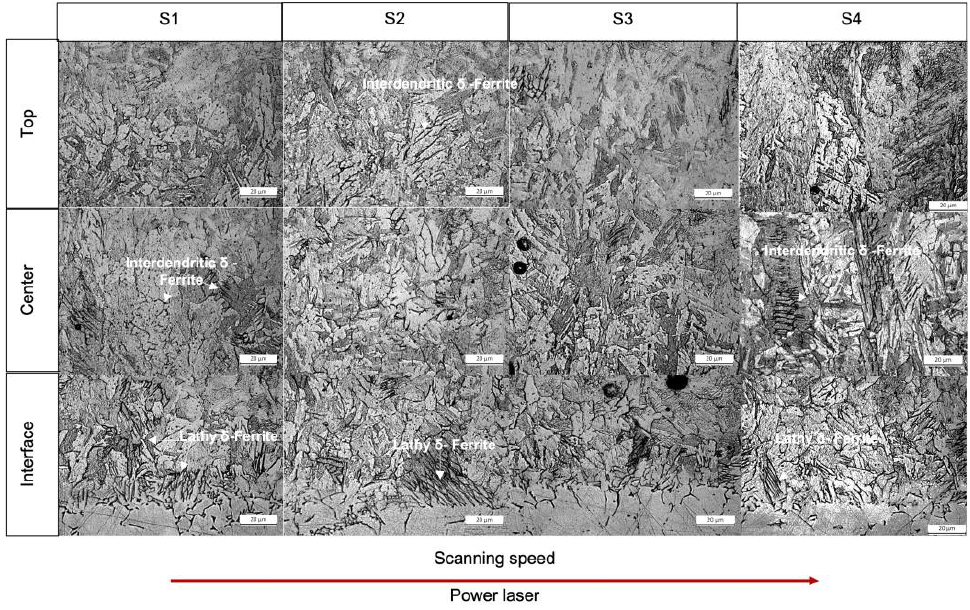
Figure 9. Evolution of microstructure across track A, zone 2, for each set of process parameters (S1 – S4).